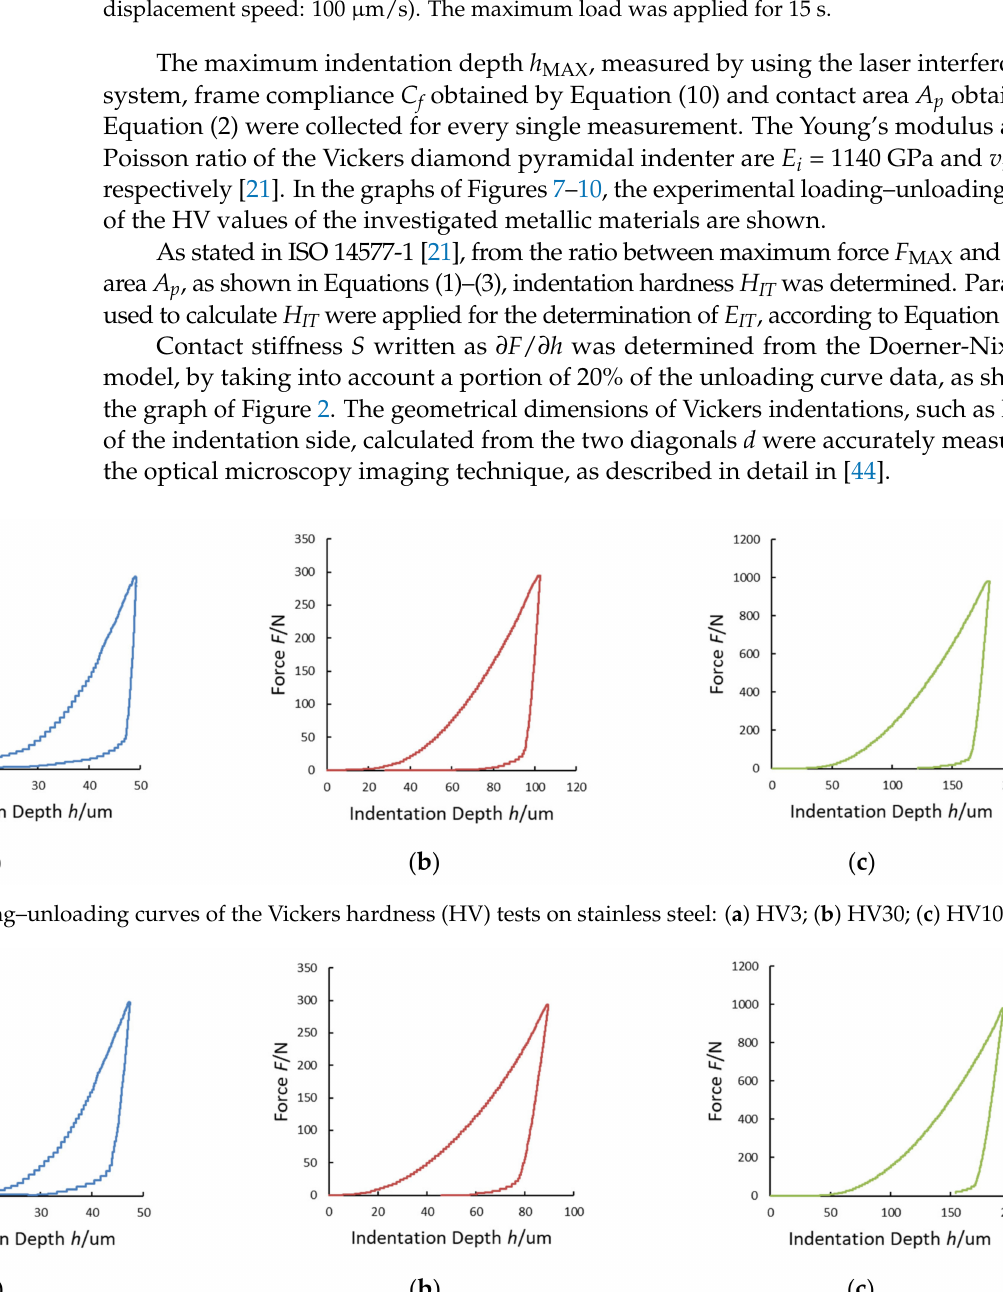
Figure 6. Experimental data of the applied load ( a ) and the indenter displacement (approaching and indentation) ( b ) of a HV100 indentation test. Forces were applied at a rate of 160 N/s (load displacement speed: 100 µ m/s). The maximum load was applied for 15 s.